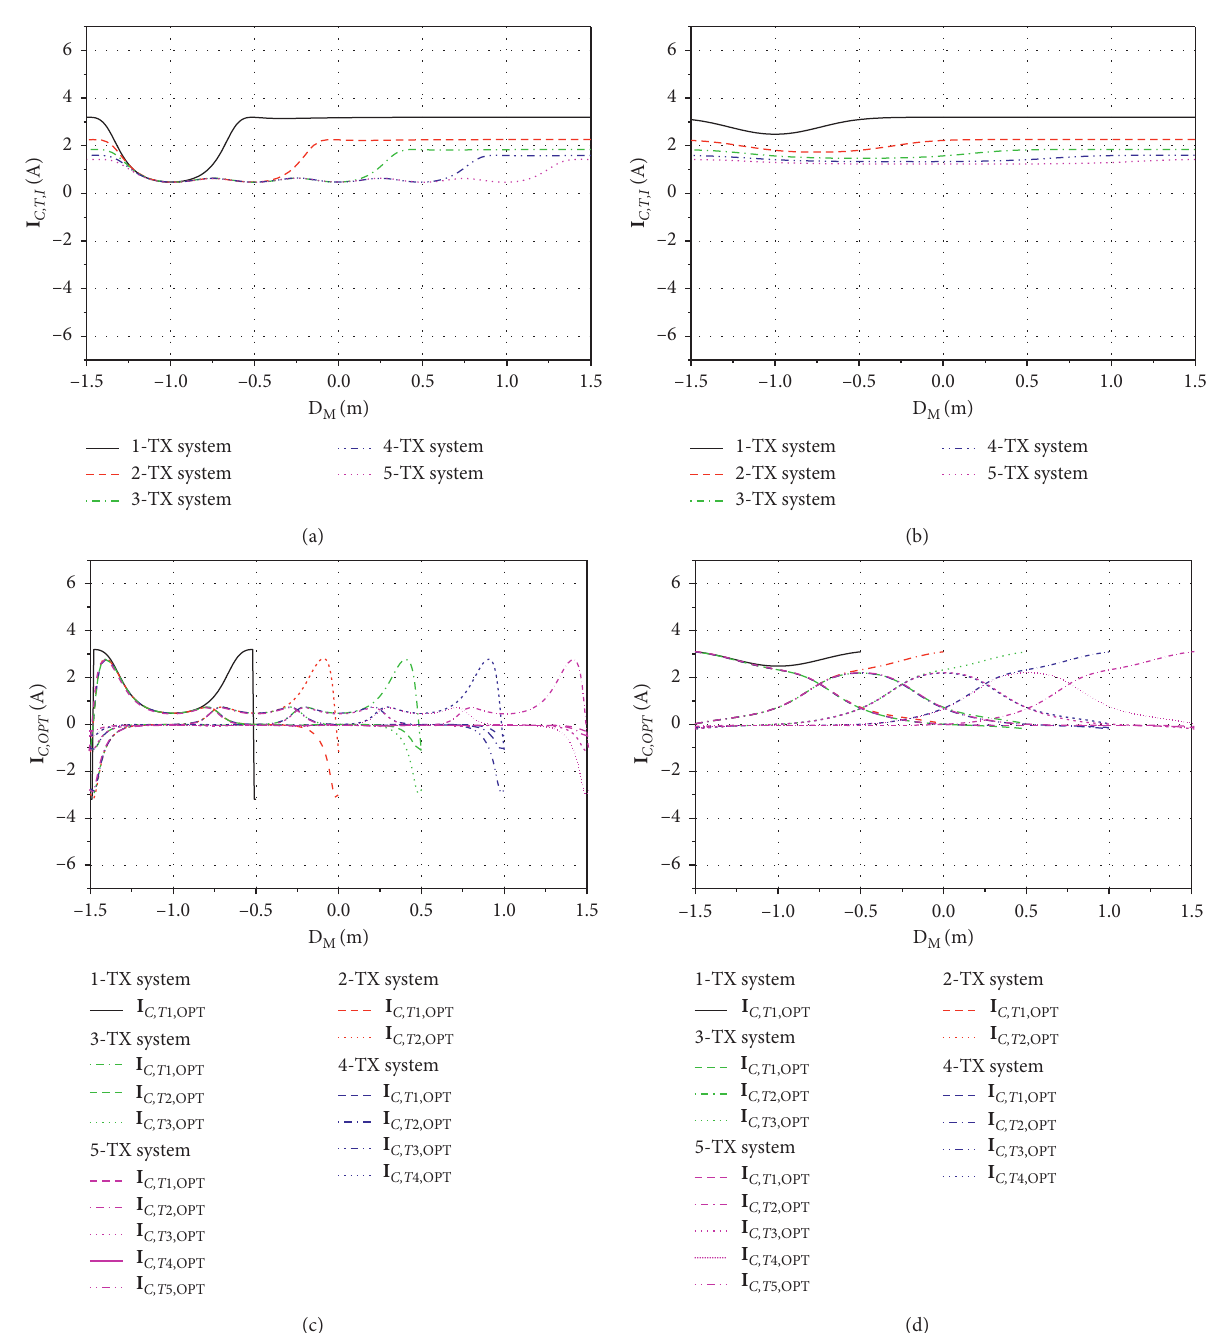
Figure 3: The currents among TXs versus D (d) D T � 0.7 m.